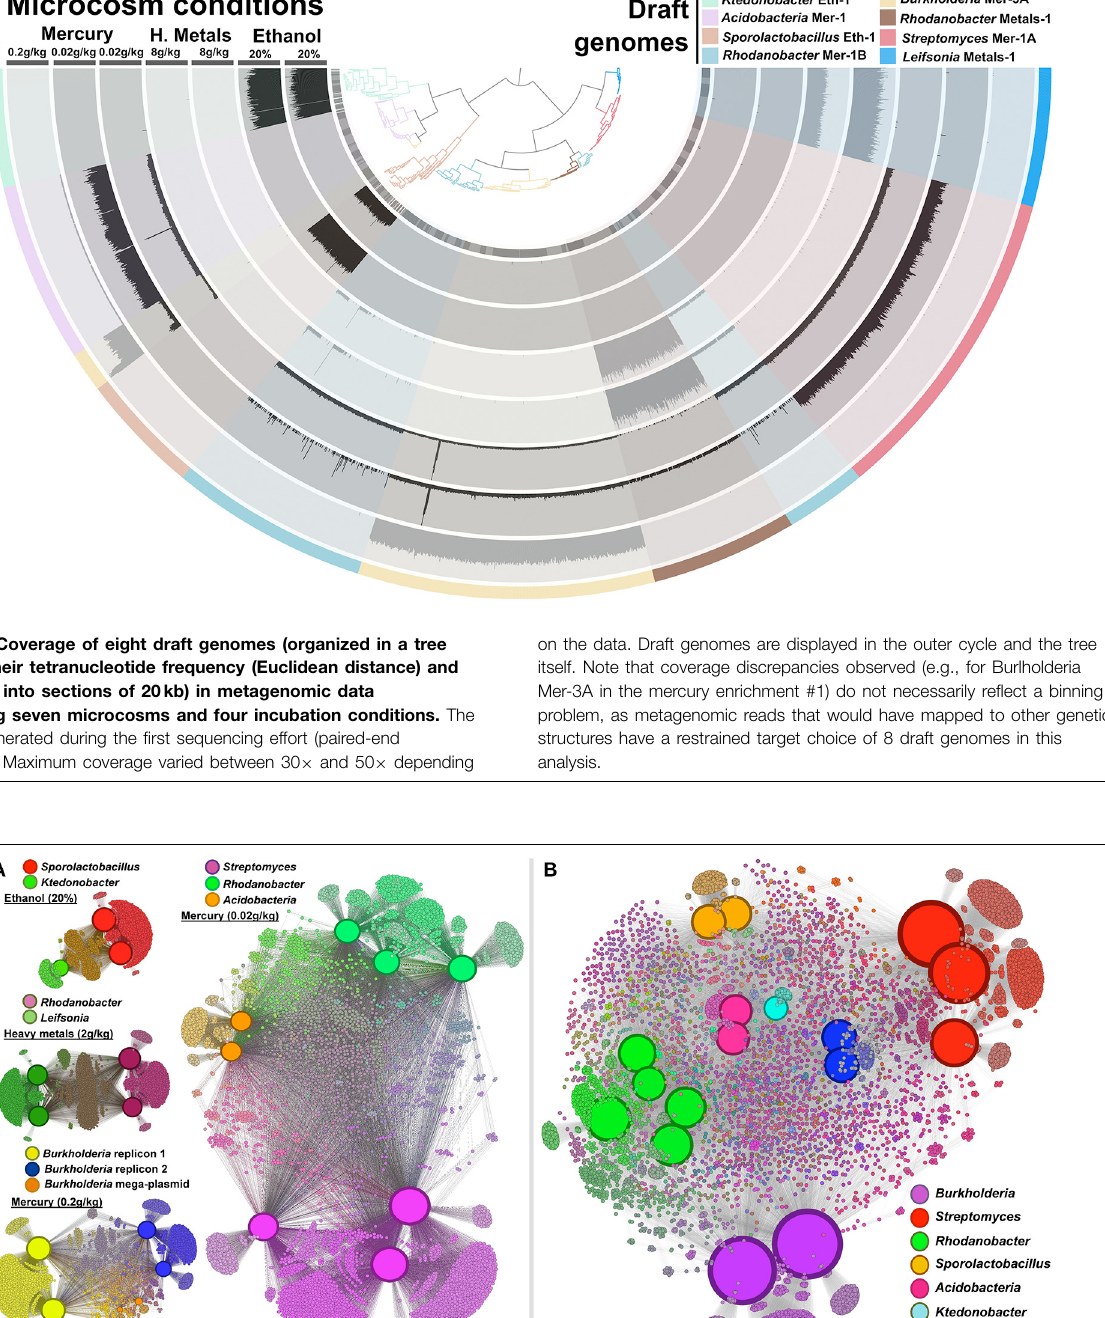
FIGURE 6 | Panel (A) functional networks linking genomes and their associated functions recovered from ethanol, heavy metals and mercury ESCs. Panel (B) functional network linking the 17 recovered genomes and their associated functions (a total of 11,299 different functions were detected). Networks were generated using Gephi and Force